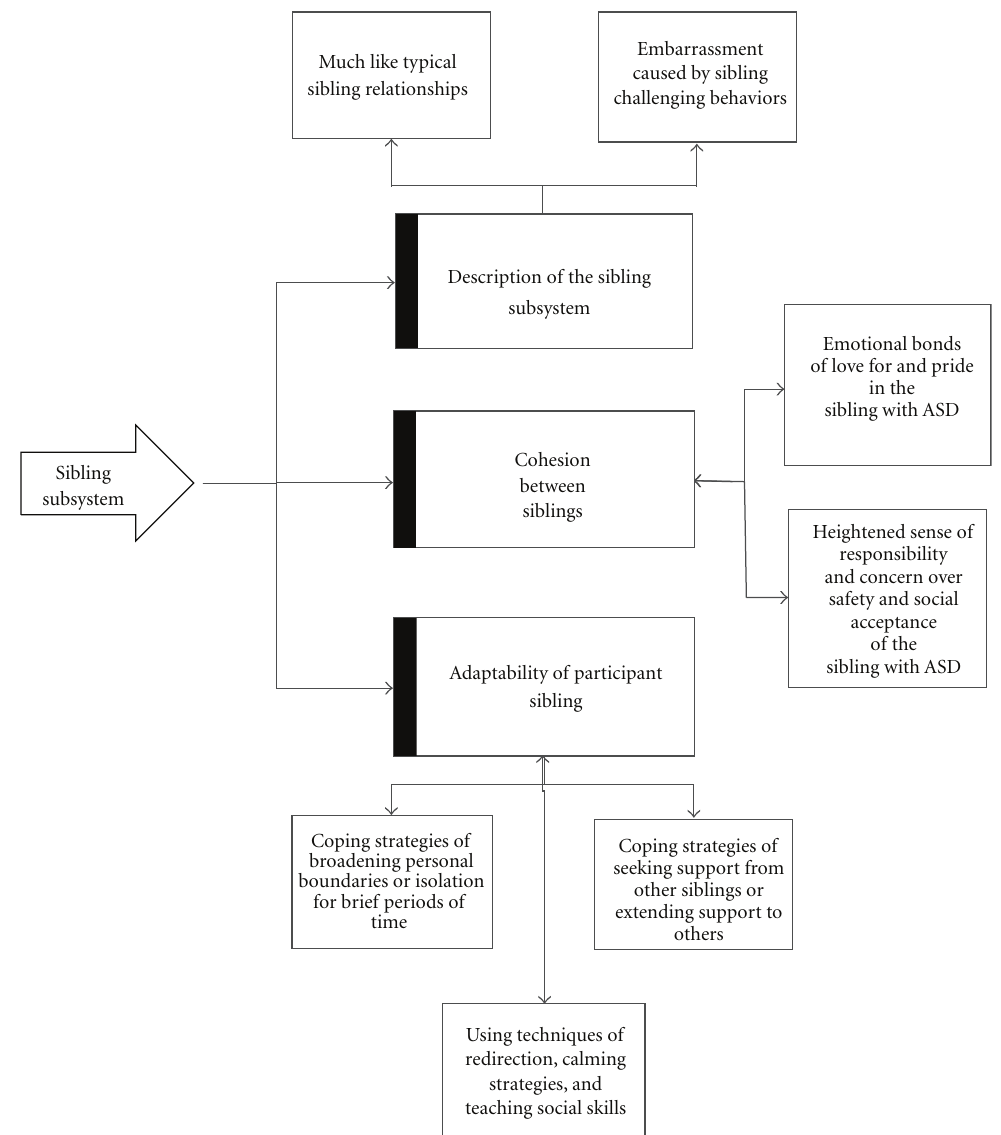
Figure 1: Graphic representation of the sibling